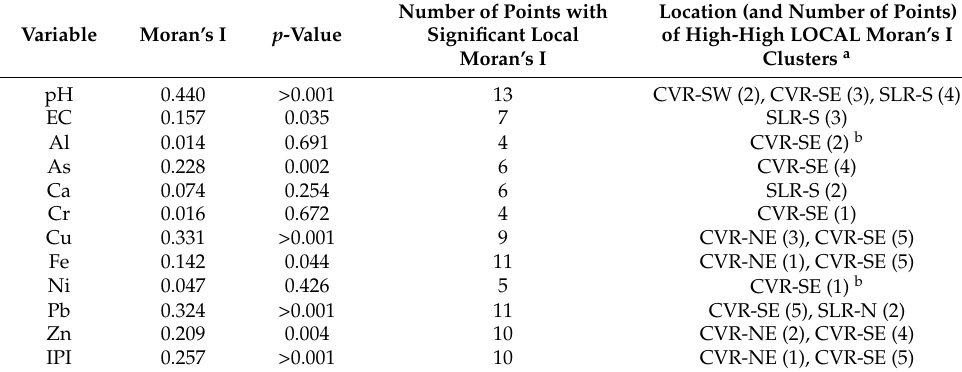
Table 3. Global Moran’s I, p -values simulated by Monte-Carlo randomization, and information on local spatial autocorrelation for the variables of principal interest in surface soil at Smith’s Lake and Charles Veryard Reserves. Variables except pH were log 10 -transformed before calculation. IPI is integrated pollution index (Equation (1)).